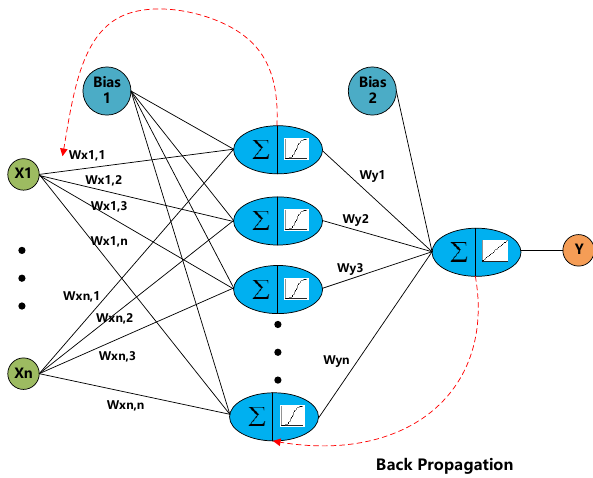
Figure 3. Architecture of MLP to develop BRANN-based models.